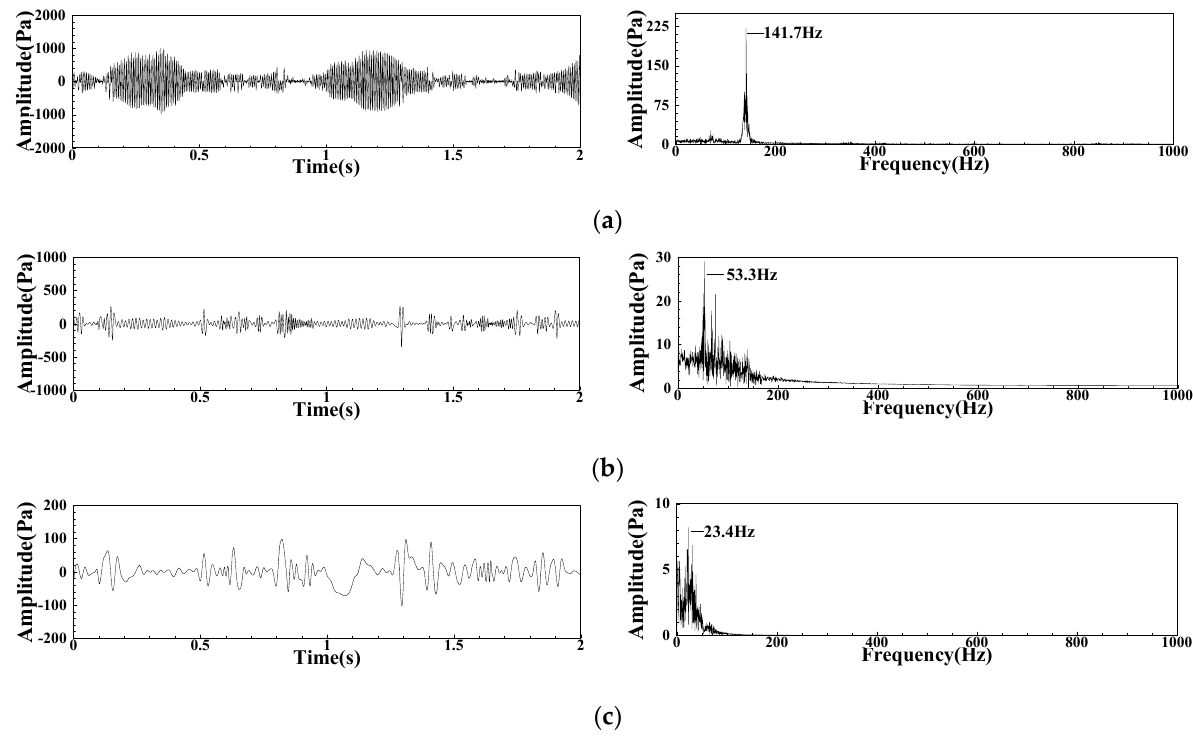
Figure 17. Waveform and spectrum of each component of DP signal under LA02: ( a ) LA02 IMF1; ( b ) LA02 IMF2; ( c ) LA02 IMF3.